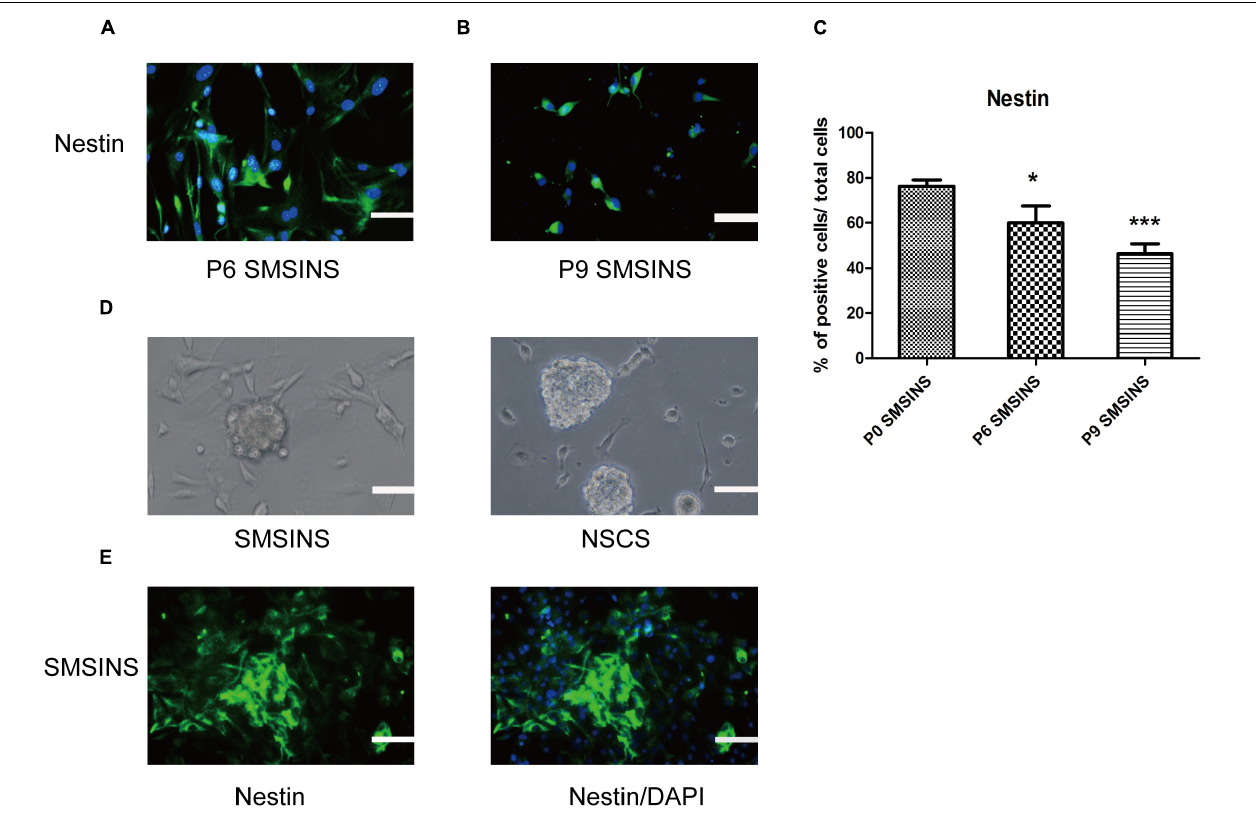
FIGURE 2 | SMSINS expressed NSC markers similar to NSCs. (A) Neuroepithelial-like colonies of SMSINS at passage 6 (P6) stained with a specific antibody against the NSC marker Nestin (Green). (B) Immunostaining of Nestin (Green) in SMSINS at passage 9 (P9). Nuclei were counterstained with DAPI (blue). (C) Quantitative analyses of the protein expression level of Nestin in SMSINS at passage 0, 6, and 9. Data represent the mean ± SEM. F = 12.39 ∗ p < 0.05; ∗∗∗ p < 0.001 compared with P0 SMSINS; One-way ANOVA followed with Dunnett’s T3 test. (D) SMSINS and native NSCs formed neural spheres when cultured in suspension. (E) Neural spheres of SMSINS stained with specific antibodies against Nestin (Green). Nuclei were counterstained with DAPI (blue). Scale bars: 100 µ m.